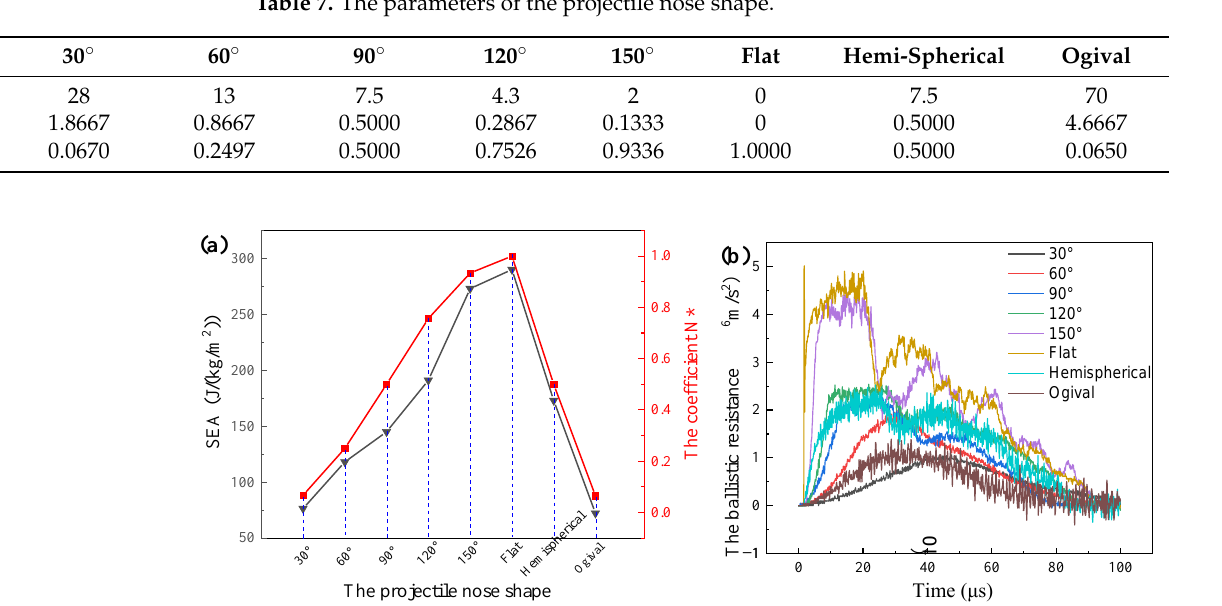
Figure 12. ( a ) The specific energy absorption of the UHMWPE composite under the penetration of various nose shape projectile and the coefficient of the projectile nose shape; ( b ) the ballistic resistance curves of projectiles.